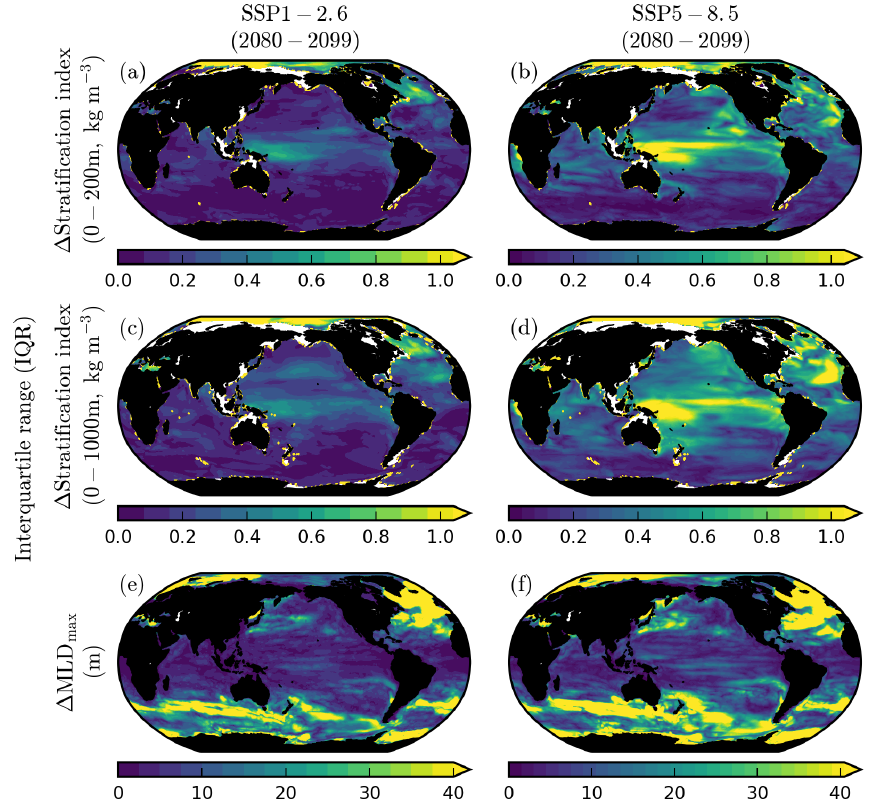
Figure A2. The interquartile range associated with CMIP6 projections of stratification and mixed-layer depth. The CMIP6 interquartile range ( Q 3 – Q 1 ) of projected anomalies in (a, b) the stratification index between 200m and the surface (kgm − 3 ), (c, d) the stratification index between 1000m and the surface (kgm − 3 ), and (e, f) the maximum annual mixed-layer depth (m). The corresponding mean projections are given in Fig.